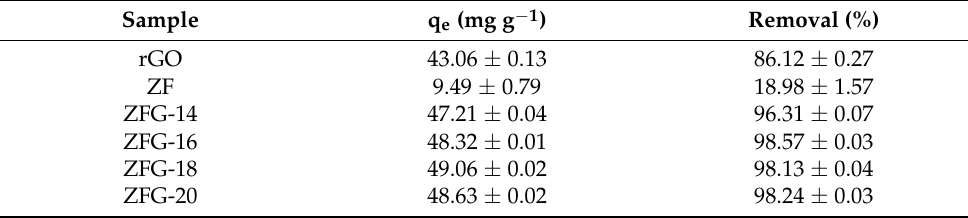
Table 3. Adsorption capacity and removal percentage of as-prepared